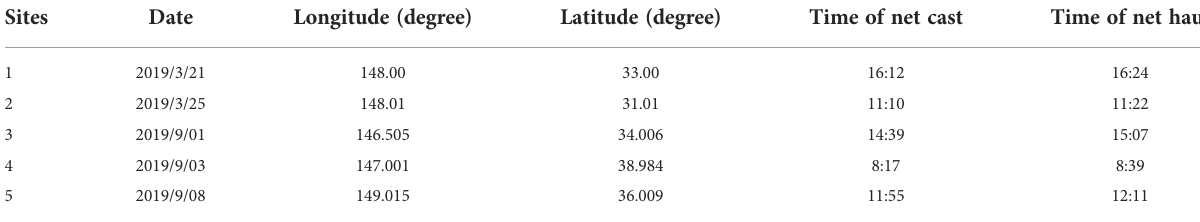
TABLE 3 Zooplankton sampling site